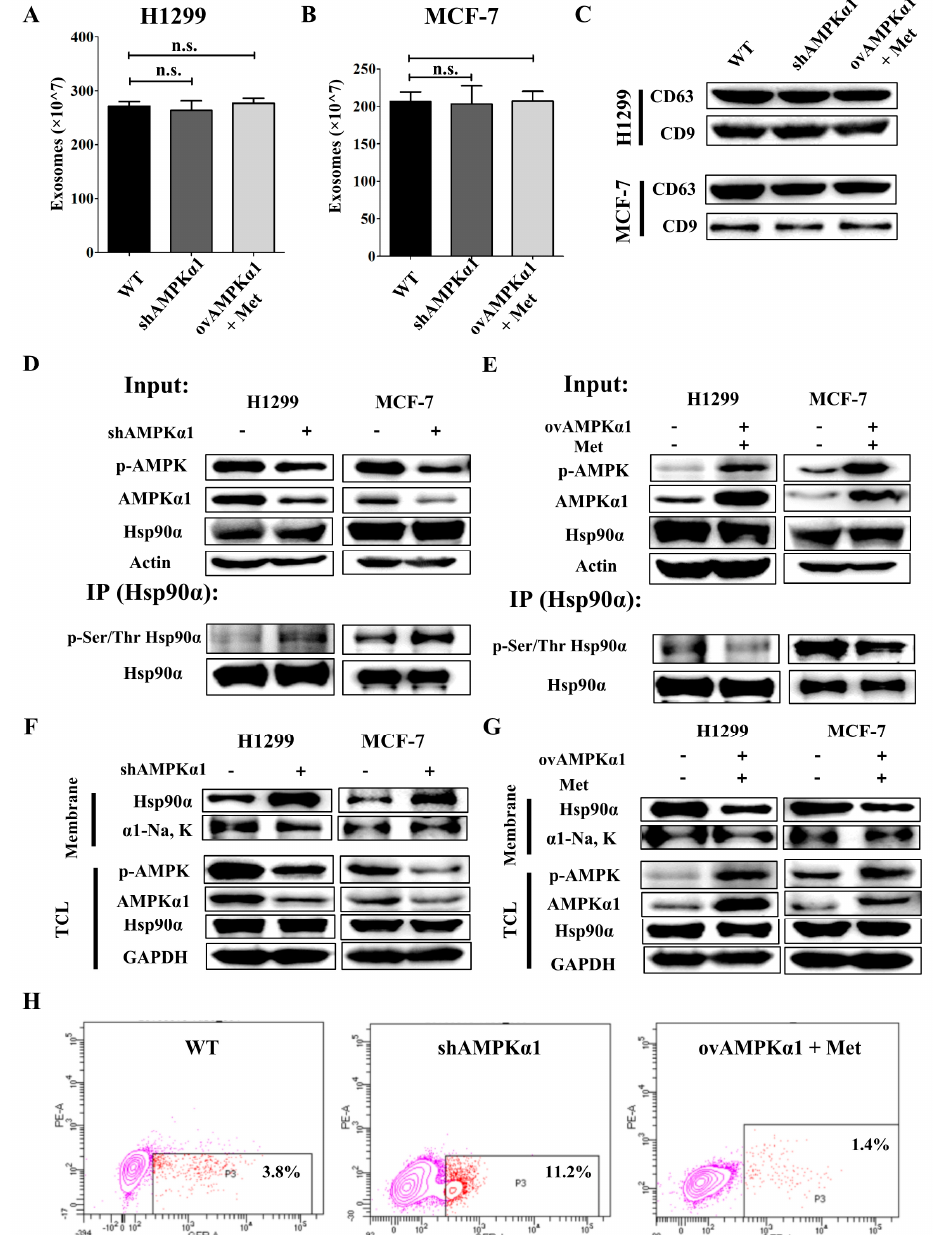
Figure 5. AMPK α 1 decreases the phosphorylation level of Hsp90 α and suppresses Hsp90 α membrane translocation. The Quantified results of exosomes in H1299 cells ( A ) and MCF-7 cells ( B ) measured by Exosomes Quantified Kit. ( C ) Western blots of CD63 and CD9 in H1299 and MCF-7 cells. ( D ) Hsp90 α was pulled down in H1299-WT, H1299-KD, MCF-7-WT and MCF-7-KD cells and the phosphorylation level at Ser / Thr was measured by western blot. ( E ) Hsp90 α was pulled down in H1299-WT, H1299-OV, MCF-7-WT and MCF-7-OV cells treated with or without metformin and the phosphorylation level at Ser / Thr was measured by western blot. ( F ) Plasma membrane extractions of H1299-WT, H1299-KD, MCF-7-WT and MCF-7-KD cells were analyzed by western blot. Na, K-ATPase α 1 was the plasma membrane marker. TCL: total cell lysate. ( G ) Plasma membrane extractions of H1299-WT, H1299-OV, MCF-7-WT and MCF-7-OV treated with or without metformin were analyzed by western blot. Na, K-ATPase α 1 was the plasma membrane marker. ( H ) Hsp90 α on the cell membrane was measured by flow cytometry in H1299-WT, KD and OV